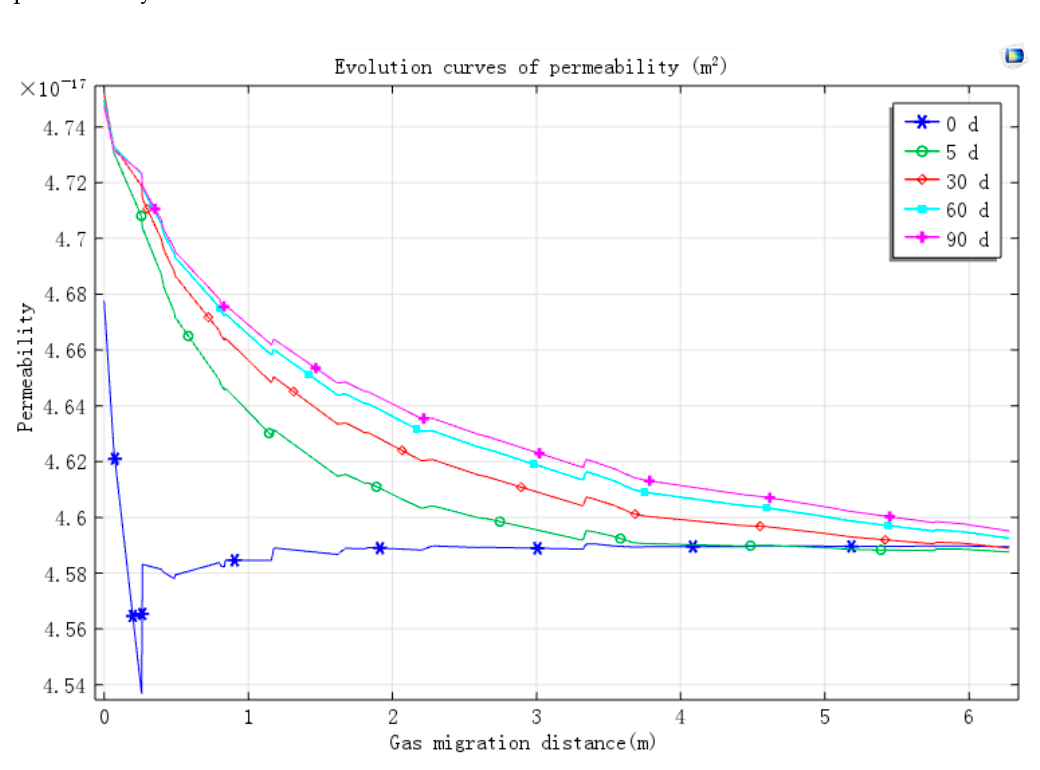
Figure 7. Evolution curves of gas pressure.